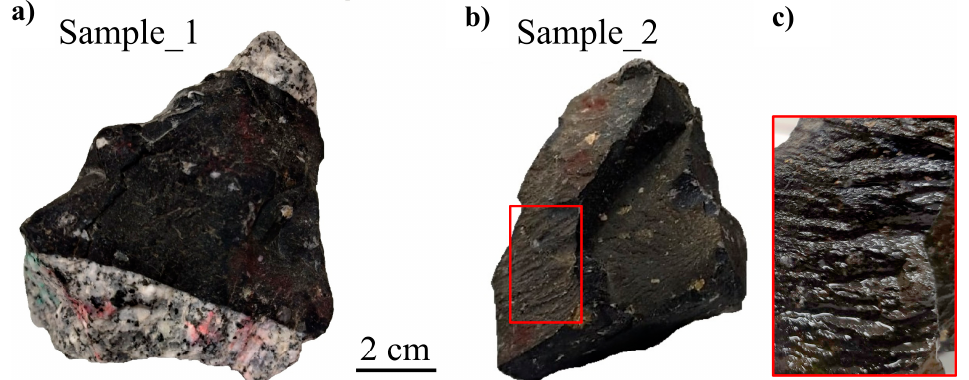
Figure 1. Photographs of the studied lamprophyre dike samples Sample_1 ( a ) and Sample_2 ( b ). Several flow-related wrinkles are highlighted by red color. The enlarged region of wrinkles is shown ( c ).